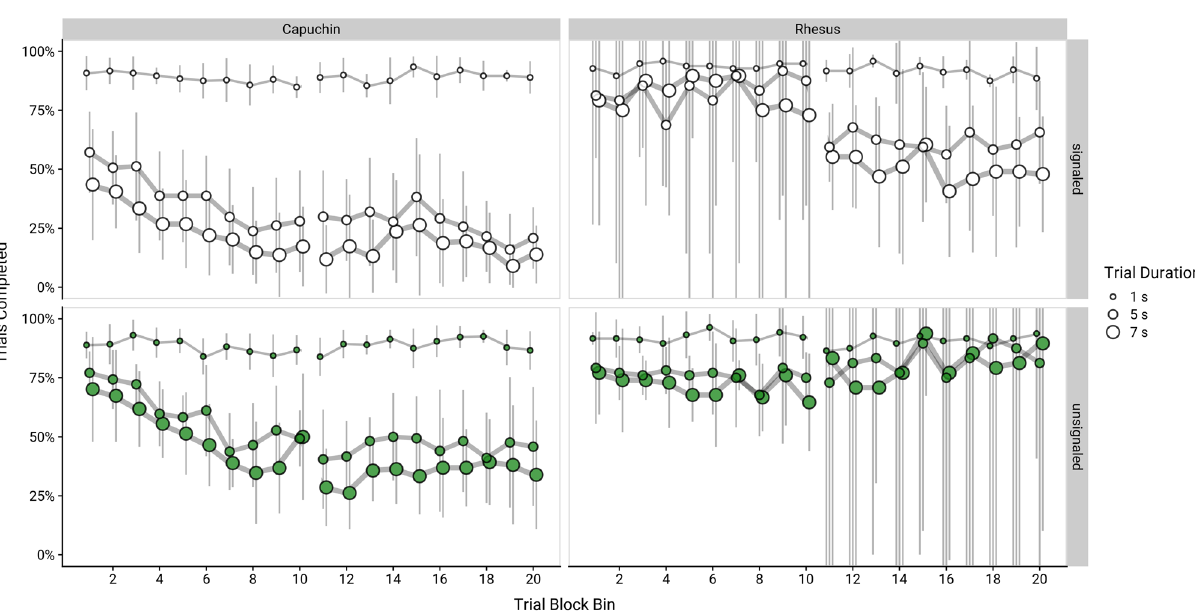
Figure 3. Trial completion by species, trial duration, condition, and trial block bin. Point ranges indicate group means and 95% confidence intervals. Bins comprised 4 blocks (96 trials). Note that monkeys completed 10 bins of each condition, either the signalled condition first (bins 1–10) and then the unsignalled second (bins 11–20), or the unsignalled condition first (bins 1–10) and the signalled second (bins 11–20). Thus, each panel shows data from different monkeys in bins 1–10 and 11–20, depending on the order that they completed the